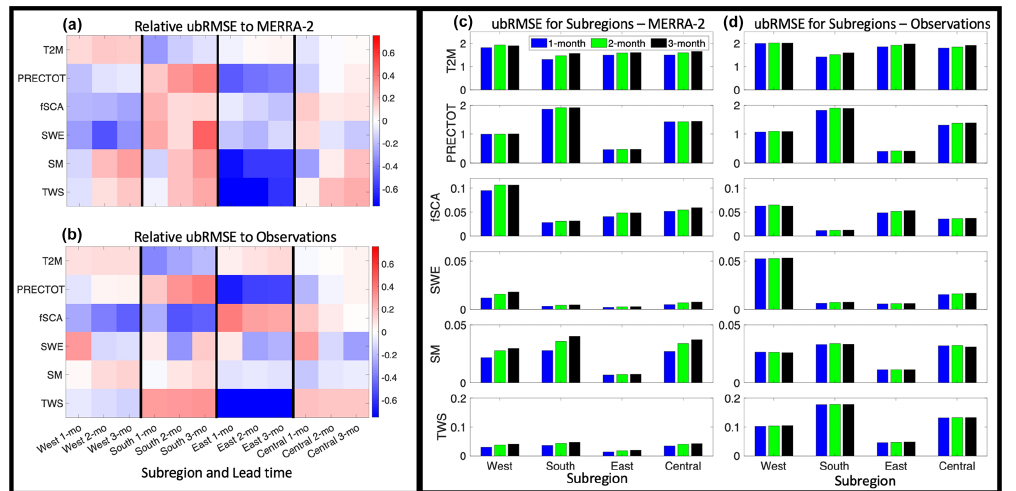
Figure 3. (a) Portrait diagram visually depicting the S2S forecast skill when evaluated against MERRA-2, comparing the skill between the different subregions (e.g., west region’s 1-month forecast for T2M). Values in each box are the ubRMSE normalized by the absolute value of the climatological mean of that variable in that region (i.e., divided by the absolute value of mean T2M for the west region), normalized again by all the skill values for that climate variable (i.e., compare each metric with the normalized ubRMSE values of T2M for all subregions and all lead times). This means that if a box is blue (red), that climate variable in that subregion for that lead time has a lower (higher) normalized error when compared to that same climate variable in other subregions and lead times. (b) Same as (a) but when evaluating against other observations. (c) Errors shown here are the original ubRMSE values for each subregion when evaluating against MERRA-2, shown for all lead times and separated by climate variable. (d) Same as (c) but when evaluating against other